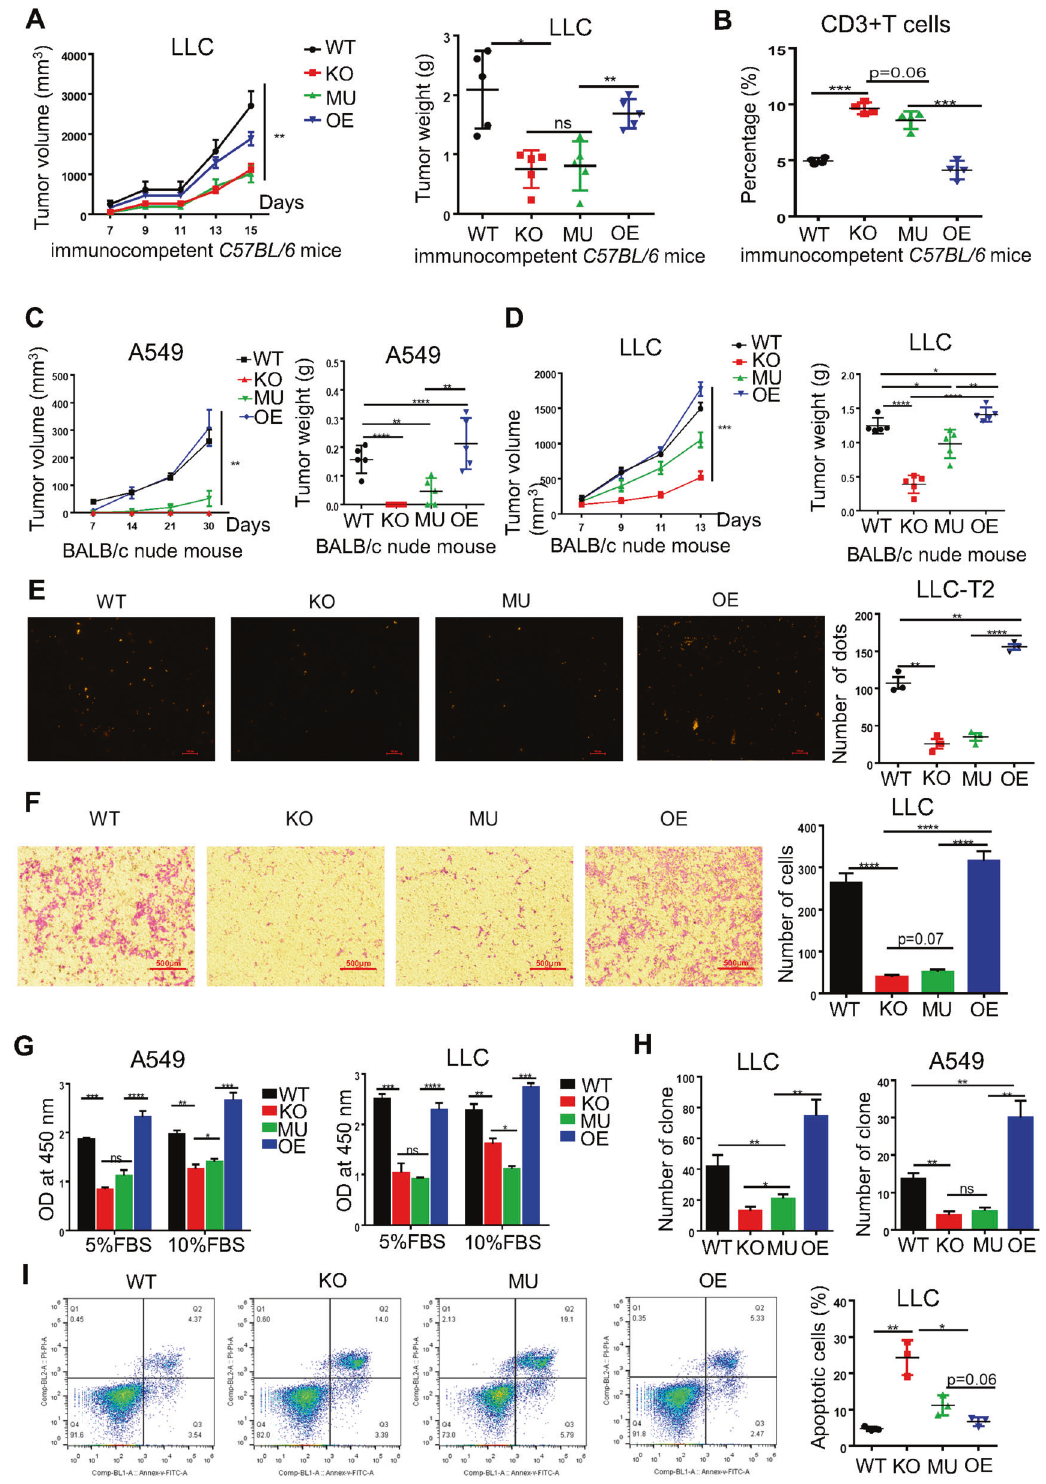
Western blotting assays Cells were lysed in RIPA lysis buffer and denatured in SDS loading buffer for total proteins. After denaturation, equal protein was separated by 10% SDS-PAGE and incubated with antibodies against CD38 (ThermoFisher, 1:500), KEAP-1 (Proteintech, 1:2000), NRF2 (CST, 1:2000), β -ACTIN (Proteintech,1:2500), GAPDH (Proteintech, 1:2000), TRPM2 (Abcam,